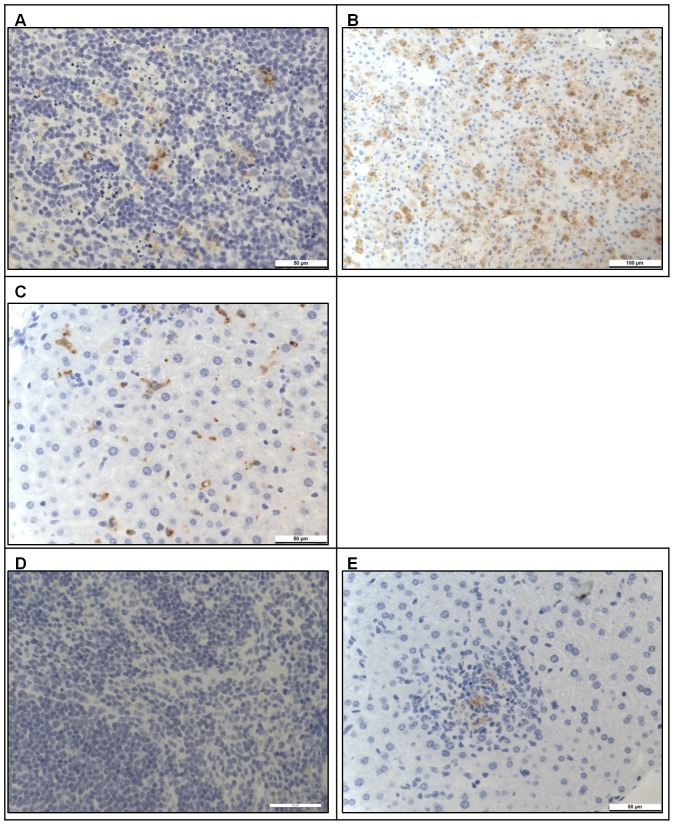
Immunohistochemistry of tissues from A129 mice, 4 days after challenge with CCHFv.A129 mice were challenged with double the minimum lethal dose of CCHFv, 14 days after booster vaccination with MVA 1974 (A–C) or MVA-GP (D–E). Four days after challenge, sections of spleen (A, D) and liver (B–C, E) were fixed, immunohistochemically stained with CCHFv-specific antibody, and examined microscopically. Tissues in panels A, B, D and E were from the same individuals as shown in Figures 7A, 7B, 7C and 7D, respectively. A diffuse staining pattern of viral proteins was found in tissues from animals that received the MVA 1974 negative control. However, in MVA-GP vaccinated animals, the only staining found was of a minimal degree, in liver from one individual. (A) A few, scattered cells with cytoplasmic staining within the parenchyma. (B) Frequent, diffuse, positively stained hepatocytes. (C) Scattered, small, elongated cells consistent with Kupffer cells, with cytoplasmic staining. (D) Normal parenchyma. (E) A few, positively stained cells within an inflammatory cell focus.